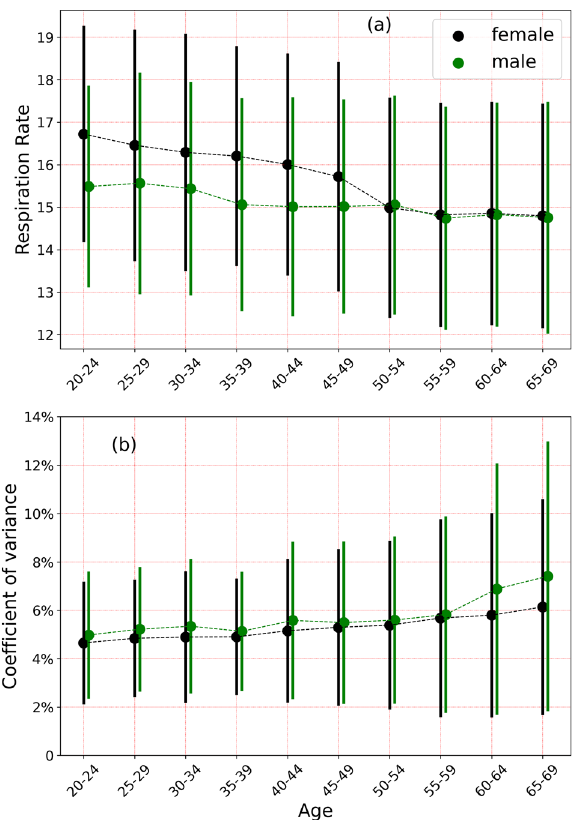
Fig. 2 Variation of respiratory rate with age and sex. a This shows the variation of respiratory rate with age and sex. Females have a higher respiratory rate on average for ages <50 yr, and no difference thereafter. b This shows the coef fi cient of variation over a 14 day period. Error bars are 1 standard deviation.